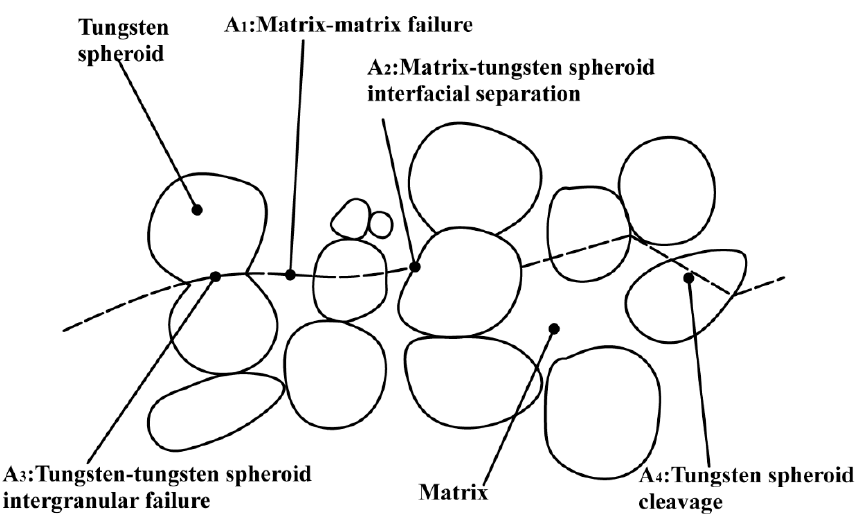
Figure 7. Schematic illustration of major failure modes in tungsten alloys. A 1 : ductile transgranular fracture of matrix phase; A 2 : intergranular fracture of matrix phase; A 3 : transgranular cleavage of W-grains; A 4 : intergranular fracture of W-grain network; A 5 : tungsten side of W-matrix interface fracture; A 6 : matrix side of W-matrix interface fracture.